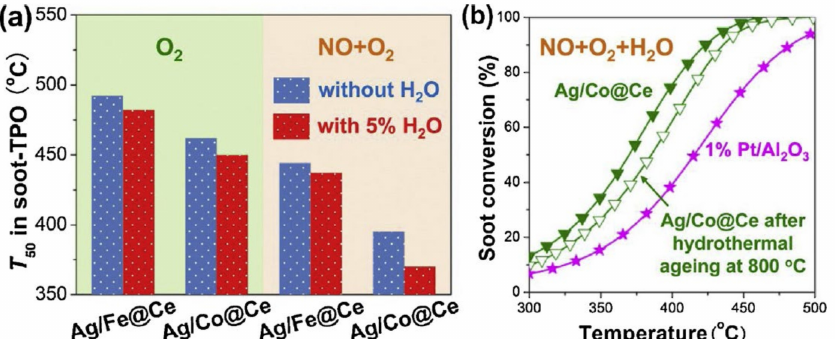
Figure 7. Soot oxidation behavior of the catalysts under ( a ) O 2 (1%) or 500(ppm NO)/O 2 (5%), with or without 5% H 2 O, and ( b ) 500(ppm NO)/O 2 (5%)/H 2 O(5%): effect of hydrothermal aging and comparison with Pt/Al 2 O 3 . Reaction conditions: catalyst/soot = 10/1 (“loose” contact mode), TPO heating rate = 5 ◦ C/min. Reproduced with permission of reference